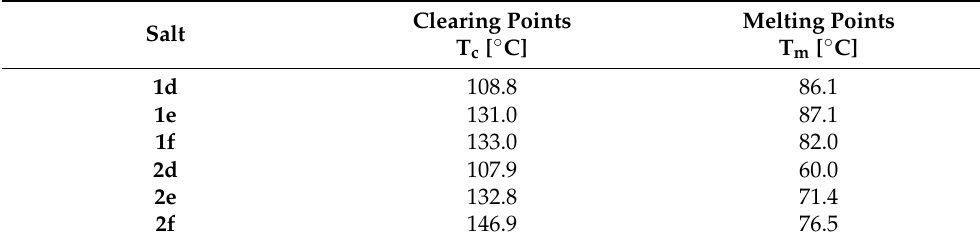
Table 1. Clearing [T c ] and Melting [T m ] points of the salts 1d-f and 2d-f with [Tf 2 N − ] as the counterion extracted from the second cooling cycle from the DSC curves.